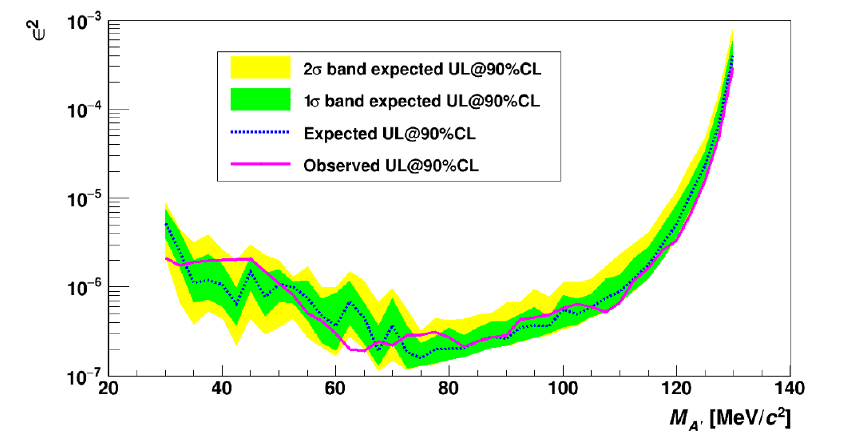
Figure 6 . Upper limits at 90% CL on the dark photon coupling strength ( (cid:15) 2 ) as a function of the mass ( M A 0 ). The limit obtained from data (solid line) should be compared to that expected in the absence of signal: the median of the upper-limit distribution in the background-only hypothesis is shown by the dashed line and the corresponding (cid:13)uctuation bands with 68% and 95% coverage are shown by the shaded